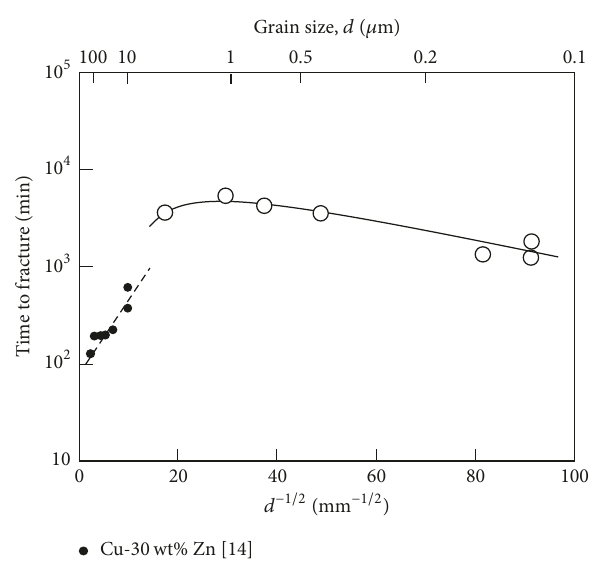
Figure 7: Relationship between time to fracture and the inverse square root of grain size in the SCC